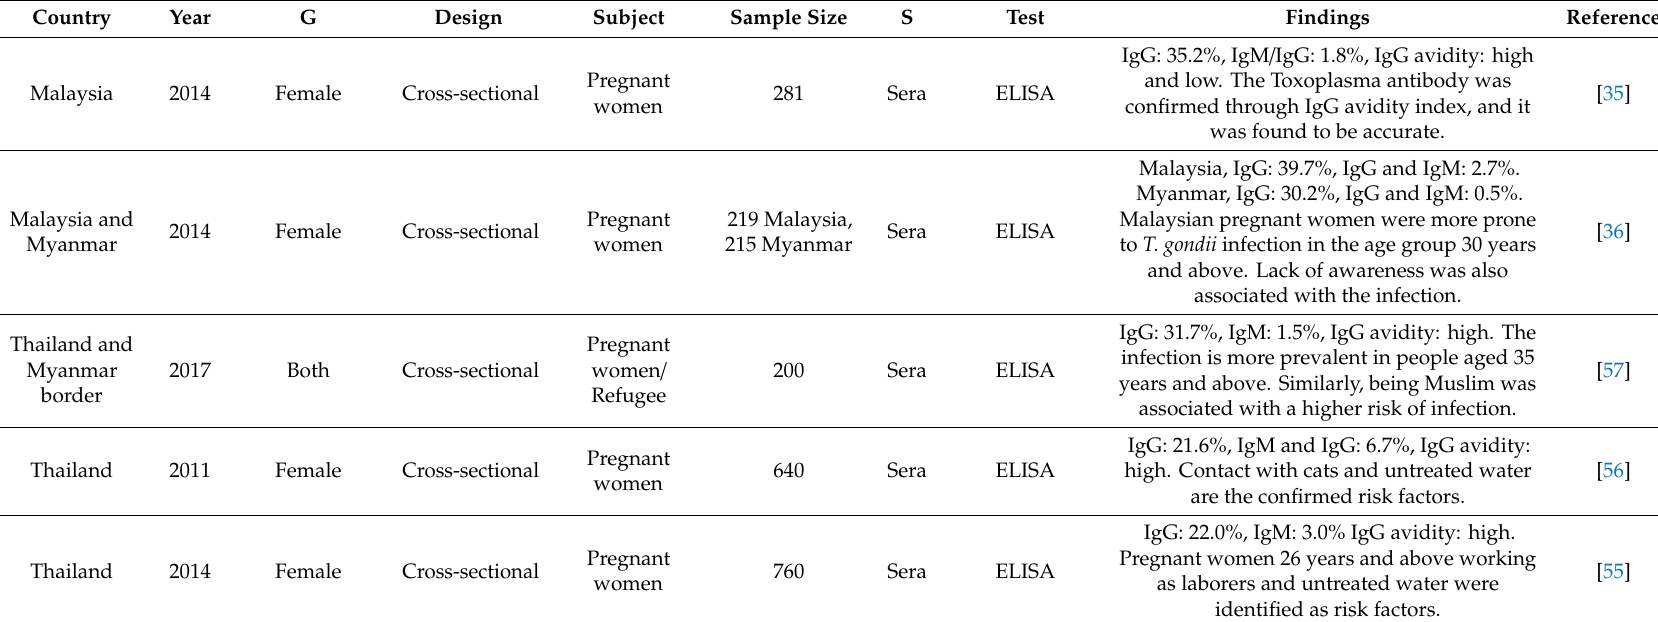
Table 2. Serological prevalence of toxoplasmosis among pregnant women in Malaysia and a link with other